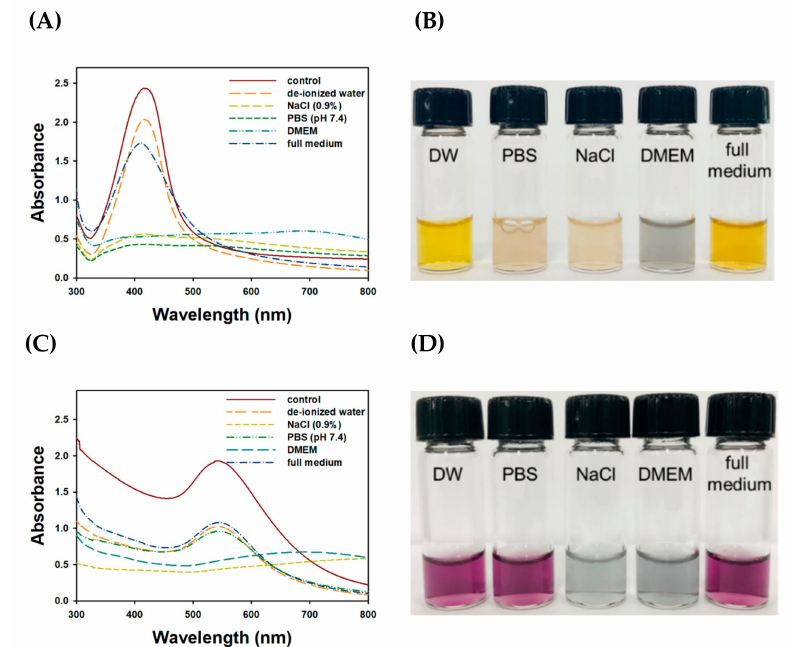
Figure 8. Assessment of colloidal stability under five di ff erent solutions: deionized water, NaCl (0.9%), phosphate-bu ff ered saline (PBS) (pH 7.4), Dulbecco’s modified Eagle’s medium (DMEM), and full medium. ( A ) UV-visible spectra of TF-AgNPs, ( B ) digital images of colloidal TF-AgNPs in ( A ) spectra,